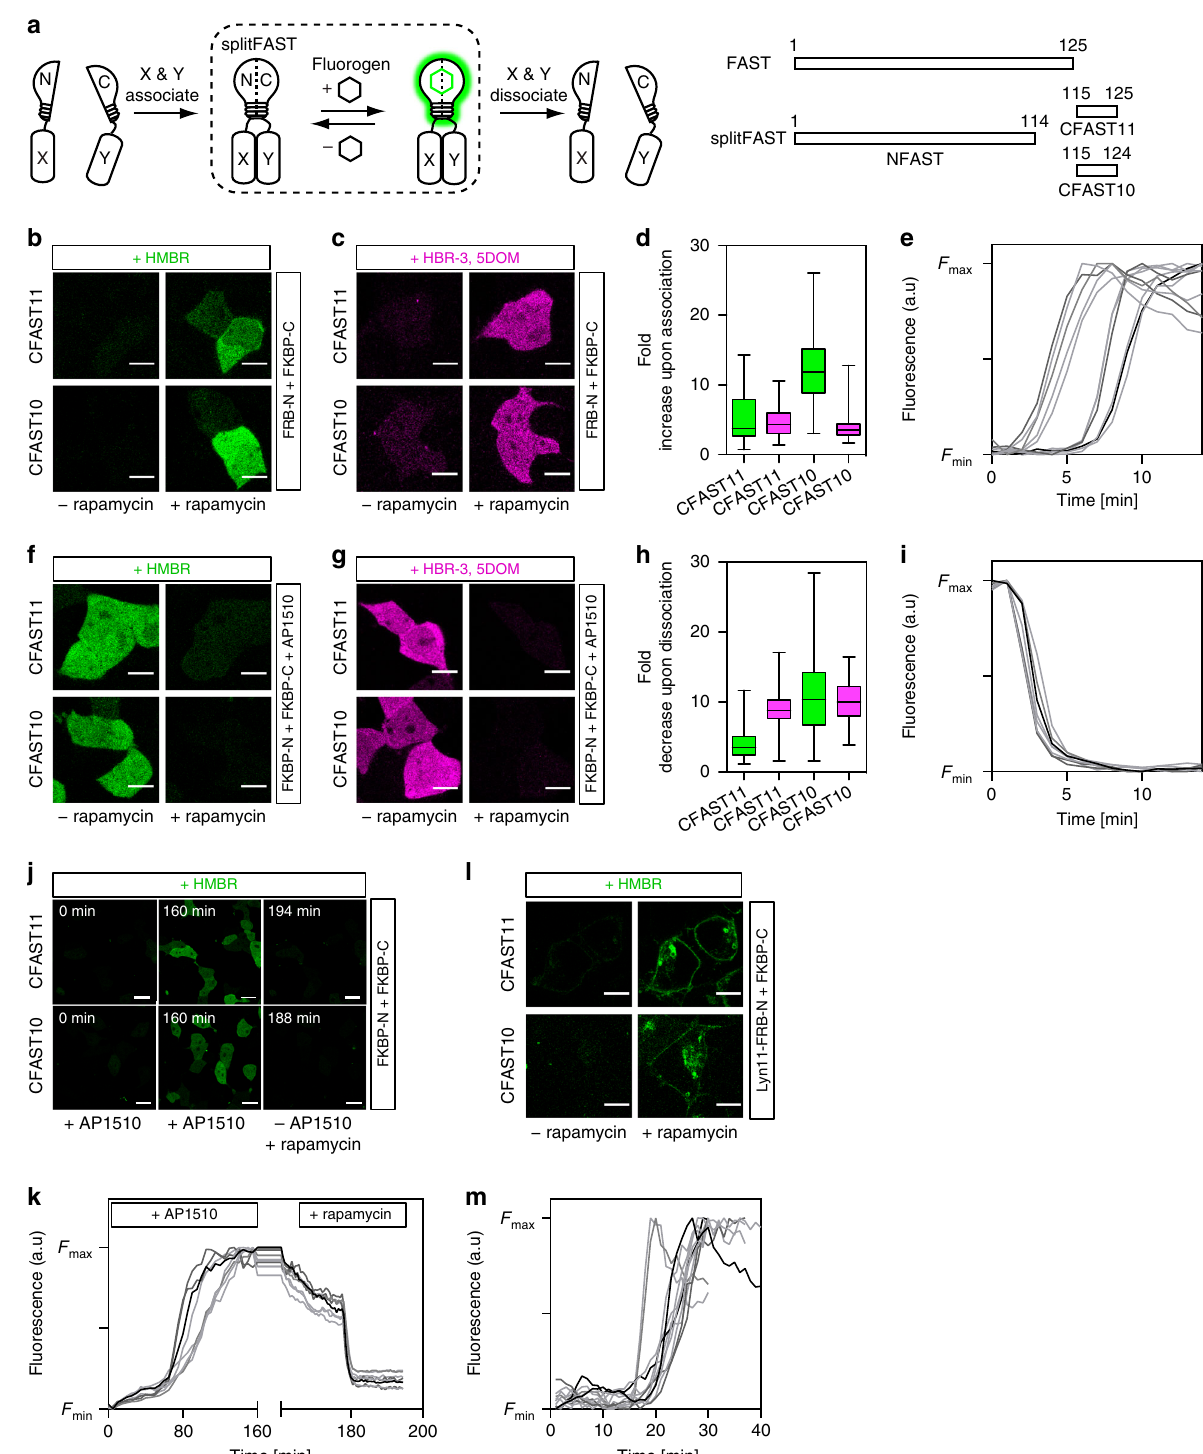
downstream of growth factor receptors, and CFAST10 was fused to an mCherry fusion of Raf1, known to be recruited to the membrane by interaction with K-Ras 11,12 . The fl uorescence of splitFAST was colocalized with that of mCherry and concentrated at the membrane, in agreement with a speci fi c recruitment of Raf1 at the plasma membrane by K-Ras (Fig. 2a and Supple- mentary Fig. 8). Next, we looked at the interaction between the MAP kinase kinase MEK1 and the downstream